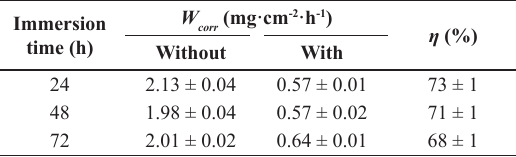
Table 4: C-steel weight loss data in 1.0 mol L -1 H and with 250 mg L -1 of methanolic Bauhinia purpurea extract at the following immersion times: 24, 48 and 72 h at 25 o C.